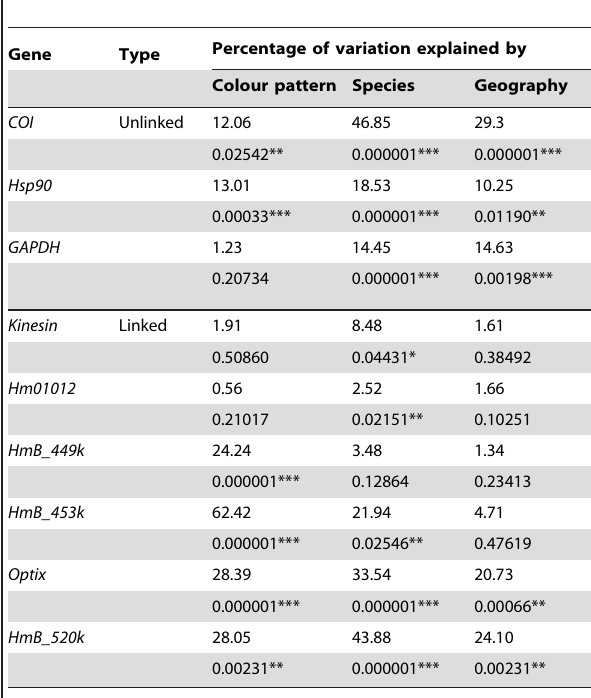
Table 1. Population structure as inferred by Analysis of Molecular Variance